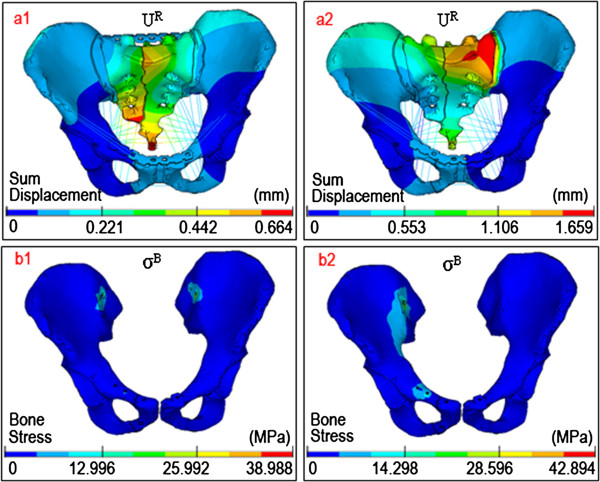
The distribution nephogram of displacements/stresses. The representative distributions of (a) the sum displacements and (b) von Mises stresses in two surgical FE models with Denis III type fractures (PTMP vs. SIJS) both under flexion states.